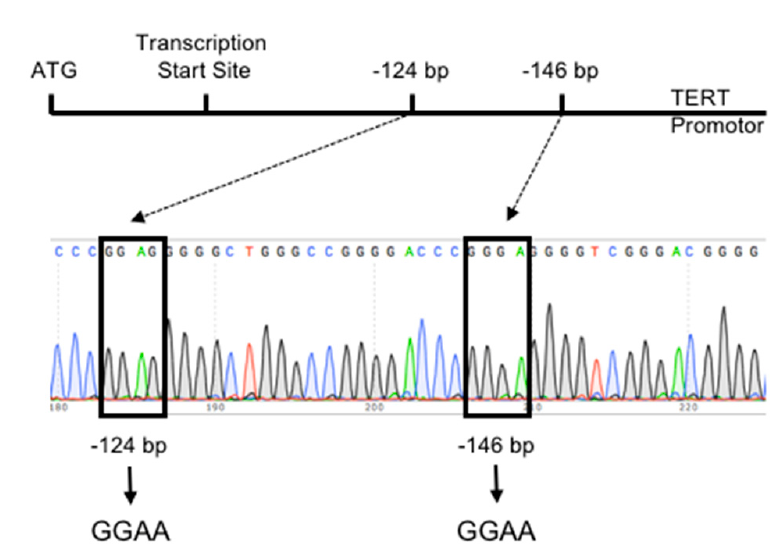
Figure 1. Identification of TERT promoter mutations in HCCs. Two hotspot mutations in the TERT promoter region generate de novo E-twenty-six (ETS) binding sites for transcription factors of the ETS family by exchange of nucleotides.